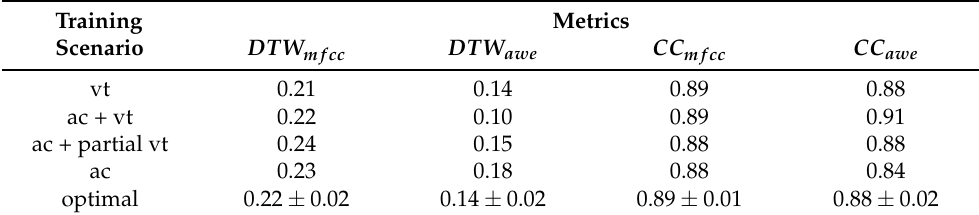
Table 3. Evaluation results for each training